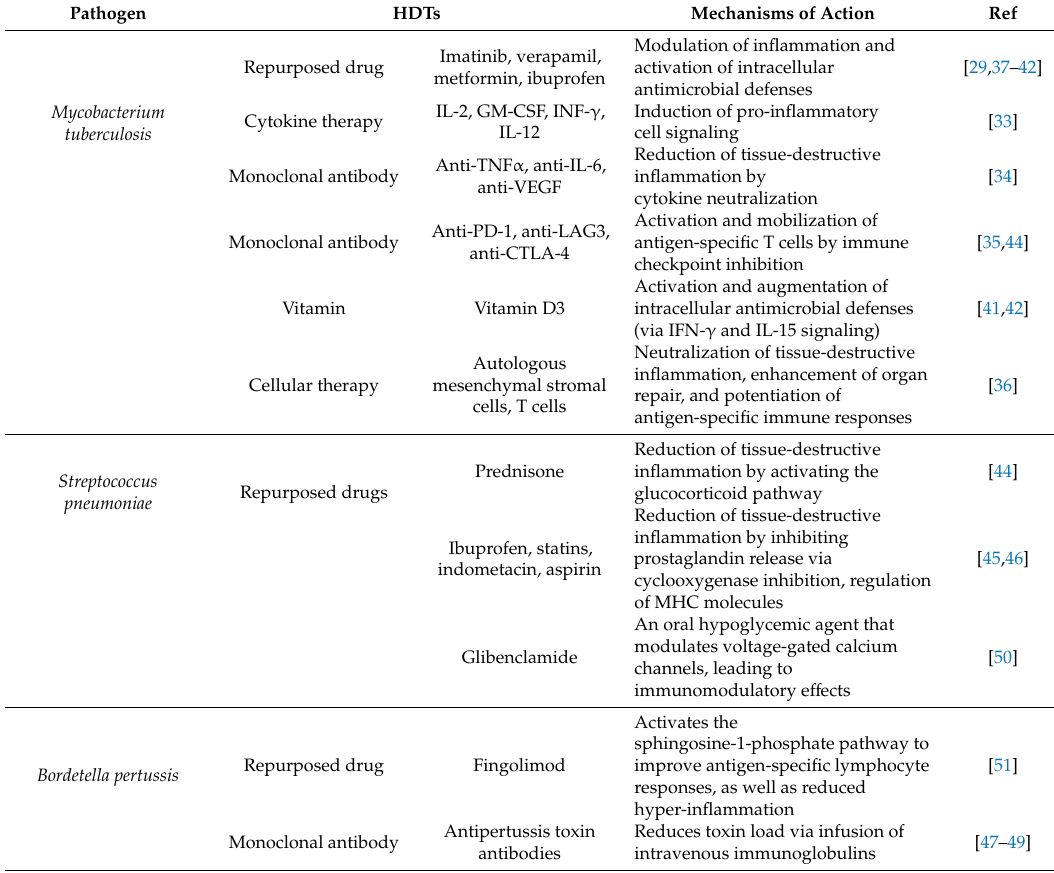
Table 1. Examples of antimicrobial host directed therapies (HDTs) and mechanisms of action (not intended to be